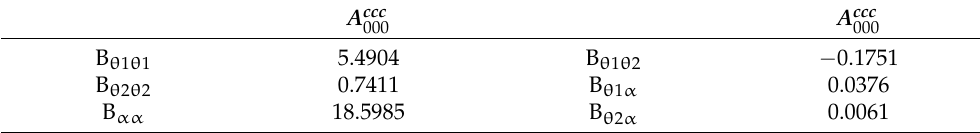
Table 5. A ccc coefficients of the kinetic energy parameters (in cm − 1 000 Table 5. 𝐴 000𝑐𝑐𝑐 coefficients of the kinetic energy parameters (in cm −1 ).